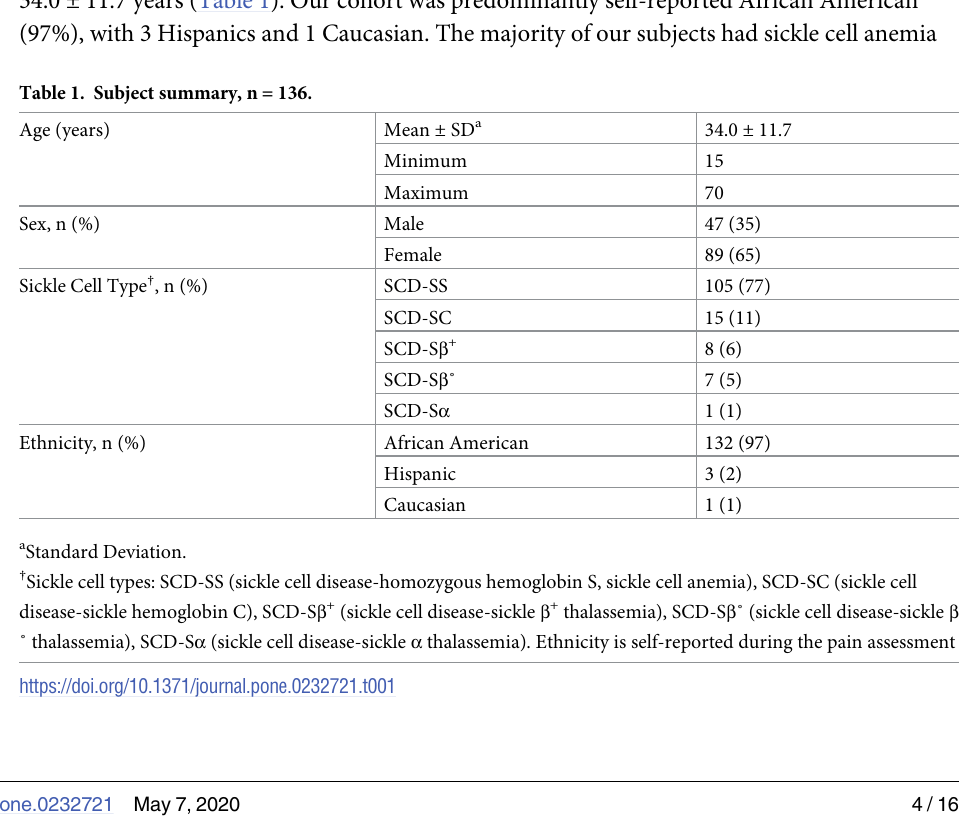
Table 1. Subject summary, n = 136.